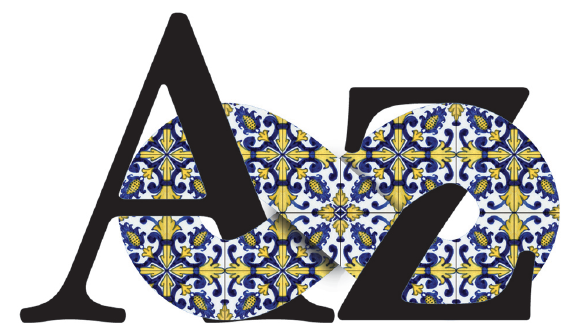
Figure 1. Logo of Az Infinitum , by Duarte Lázaro (2012), with the pattern